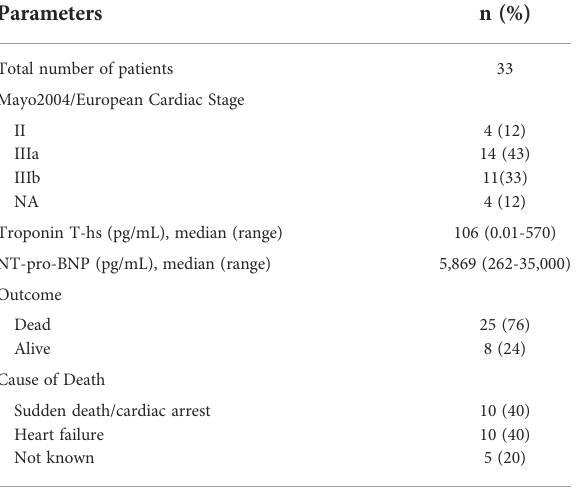
TABLE 2 Patients ’ with cardiac amyloidosis